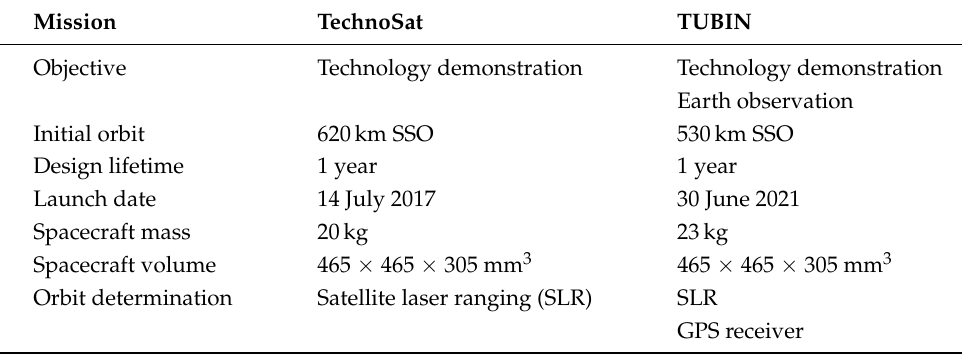
Table 1. Summary of the TechnoSat and TUBIN satellite